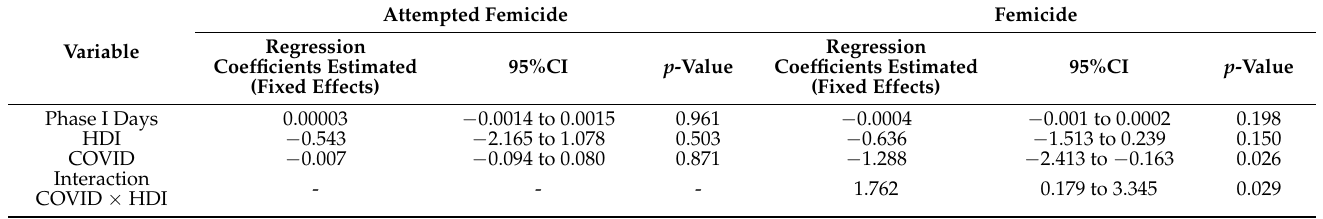
Table 1. Mixed models to evaluate the relationships of COVID-19 and HDI with the attempted- femicide and femicides